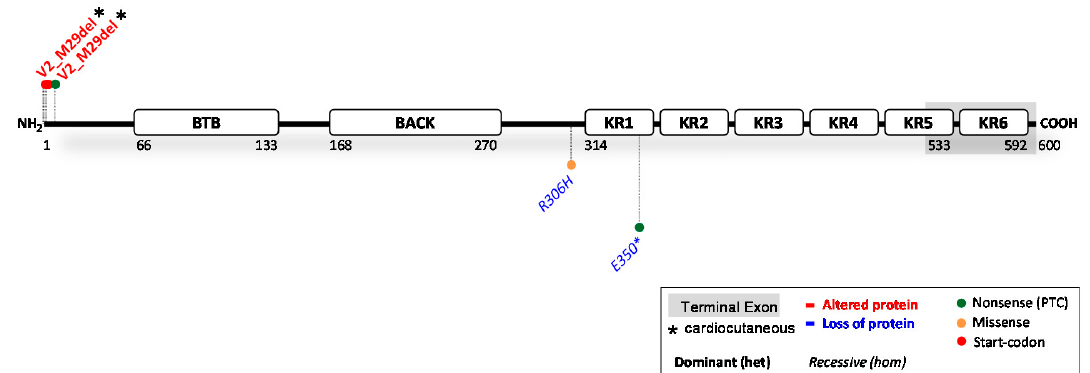
Figure 5. Location of functionally investigated KLHL24 variants.